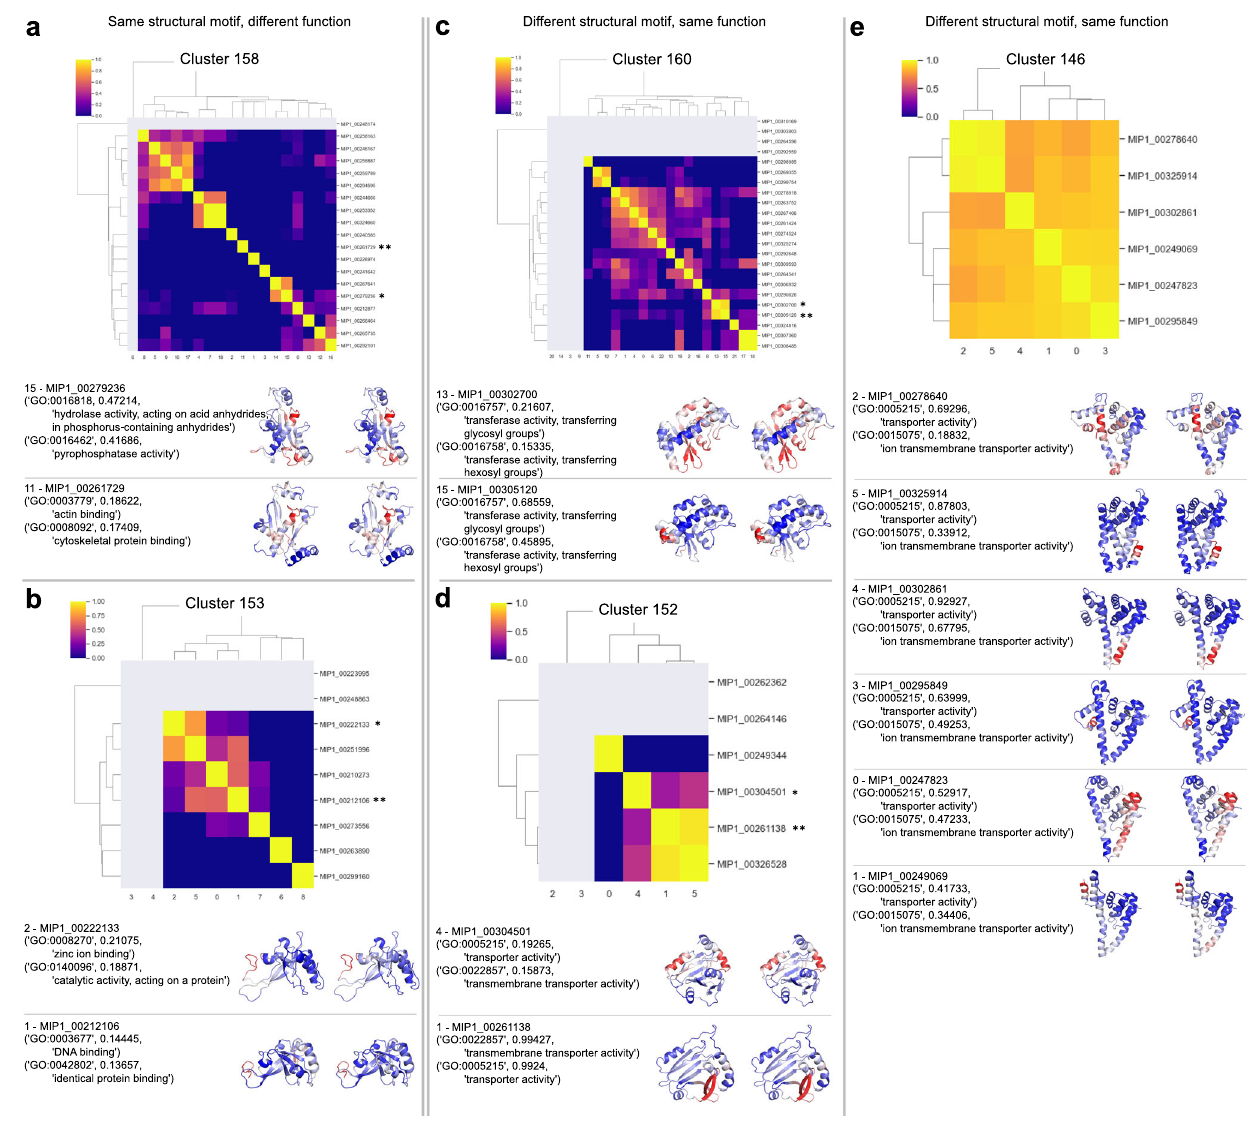
Fig. 3 | Functional diversity of proteins with the same structure. We show examplesfromseveralstructuralclusters(Rosettamodels)thatexhibitnovelfolds. The heatmaps show functional similarity (cosine similarity of the functionvectors) of protein pairs within the cluster. Proteins that have predicted functions with scores <0.1 are shown in gray in the heatmaps. Asterisks highlight the examples